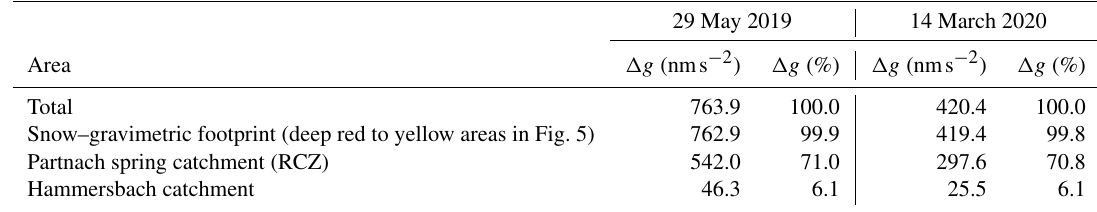
Table 3. Gravity contributions from modelled snowpack of various areas with regard to ZUGOG at maximum seasonal gravity residuals